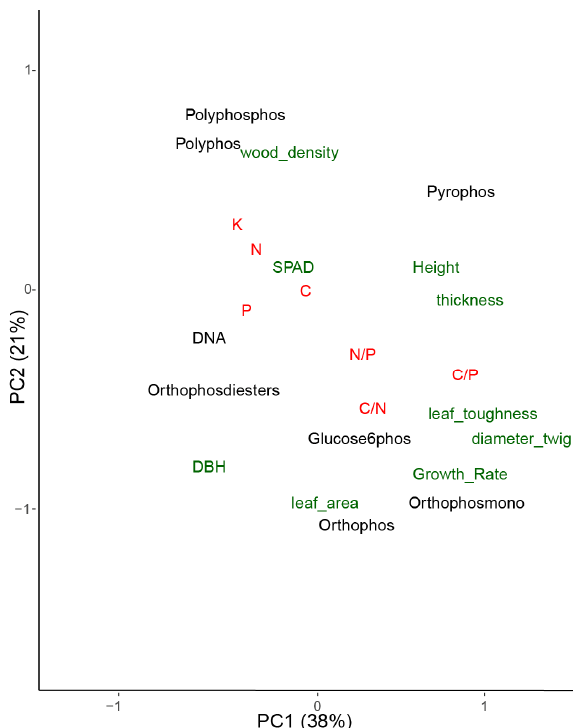
Figure 1. Principal components analysis (PCA) of P organic compounds and elements in leaf material among ( A ) species and ( B ) variables. In panel B, metabolomic families are in black text; ecophysiological variables are in green text; and stoichiometric variables are in red text. Polyphos—polyphosphate; pyrophos—pyrophosphate; polyphosphos—polyphosphonate; orthophosphate (orthophos), orthophosphate monosester (orthomono), orthophos—orthophosphate-diester; glucose6phos—glucose-6phosphates; SPAD—chlorophyll content; C—carbon; N—nitrogen; K— potassium; P—phosphorus. the closest tree species to each sampling point with the corresponding S.D. (B). The abbreviation of the legend refer to the closest tree species: Aro— Aniba rosaeodora; Bpr—